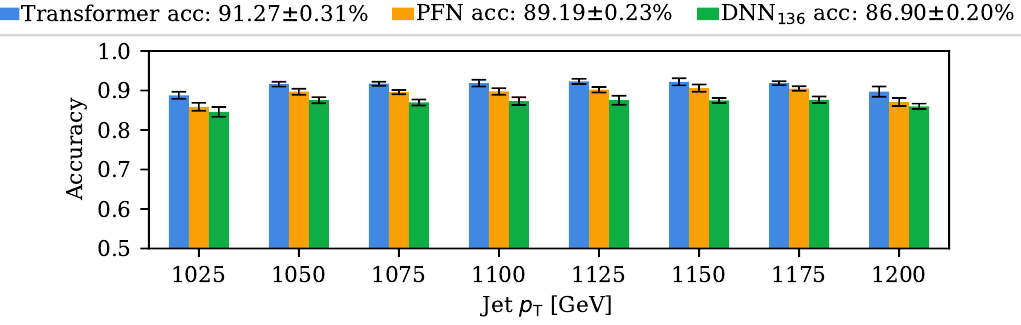
Figure 6 . Mean 10-fold accuracy and statistical uncertainty of the network prediction for jets within ranges of jet p T , for the three network studies. The jets are binned according to their p T in intervals of 25 GeV. The x-axis labels correspond to the upper bound of the intervals.